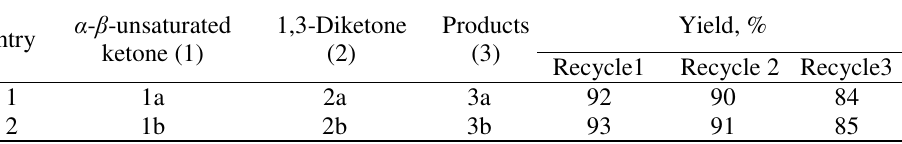
Table 3 . Recovery of ZnCl loaded on montmorillonite K - 10 catalyst in the synthesis of 2,4- 2 diphenyl-4 H